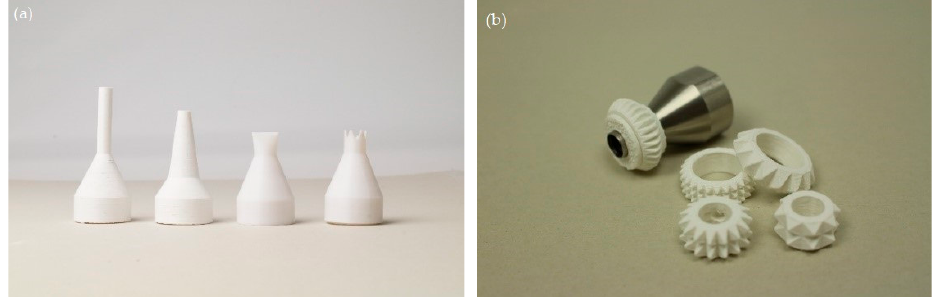
Figure 3. Developed nozzle ( a ), and stamp Tools in PLA ( b